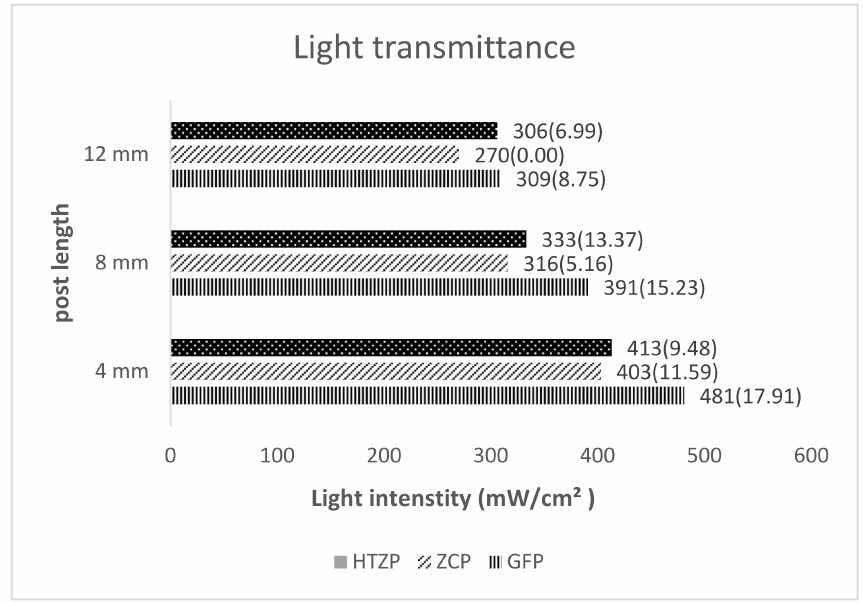
Figure 5. Mean light intensity (mW/cm 2 ) among the different post at various depth. HTZP: highly translucent zirconium oxide posts; GFP: glass fiber posts; ZCP: zirconia ceramic